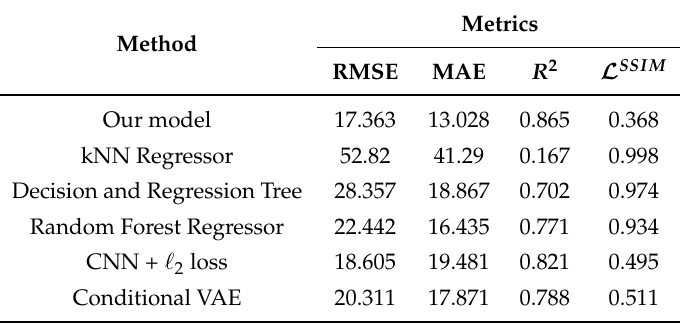
Table 3. The quantitative evaluation employed in our model and baselines, with the metrics of RMSE, MAE, R 2 and L SSIM